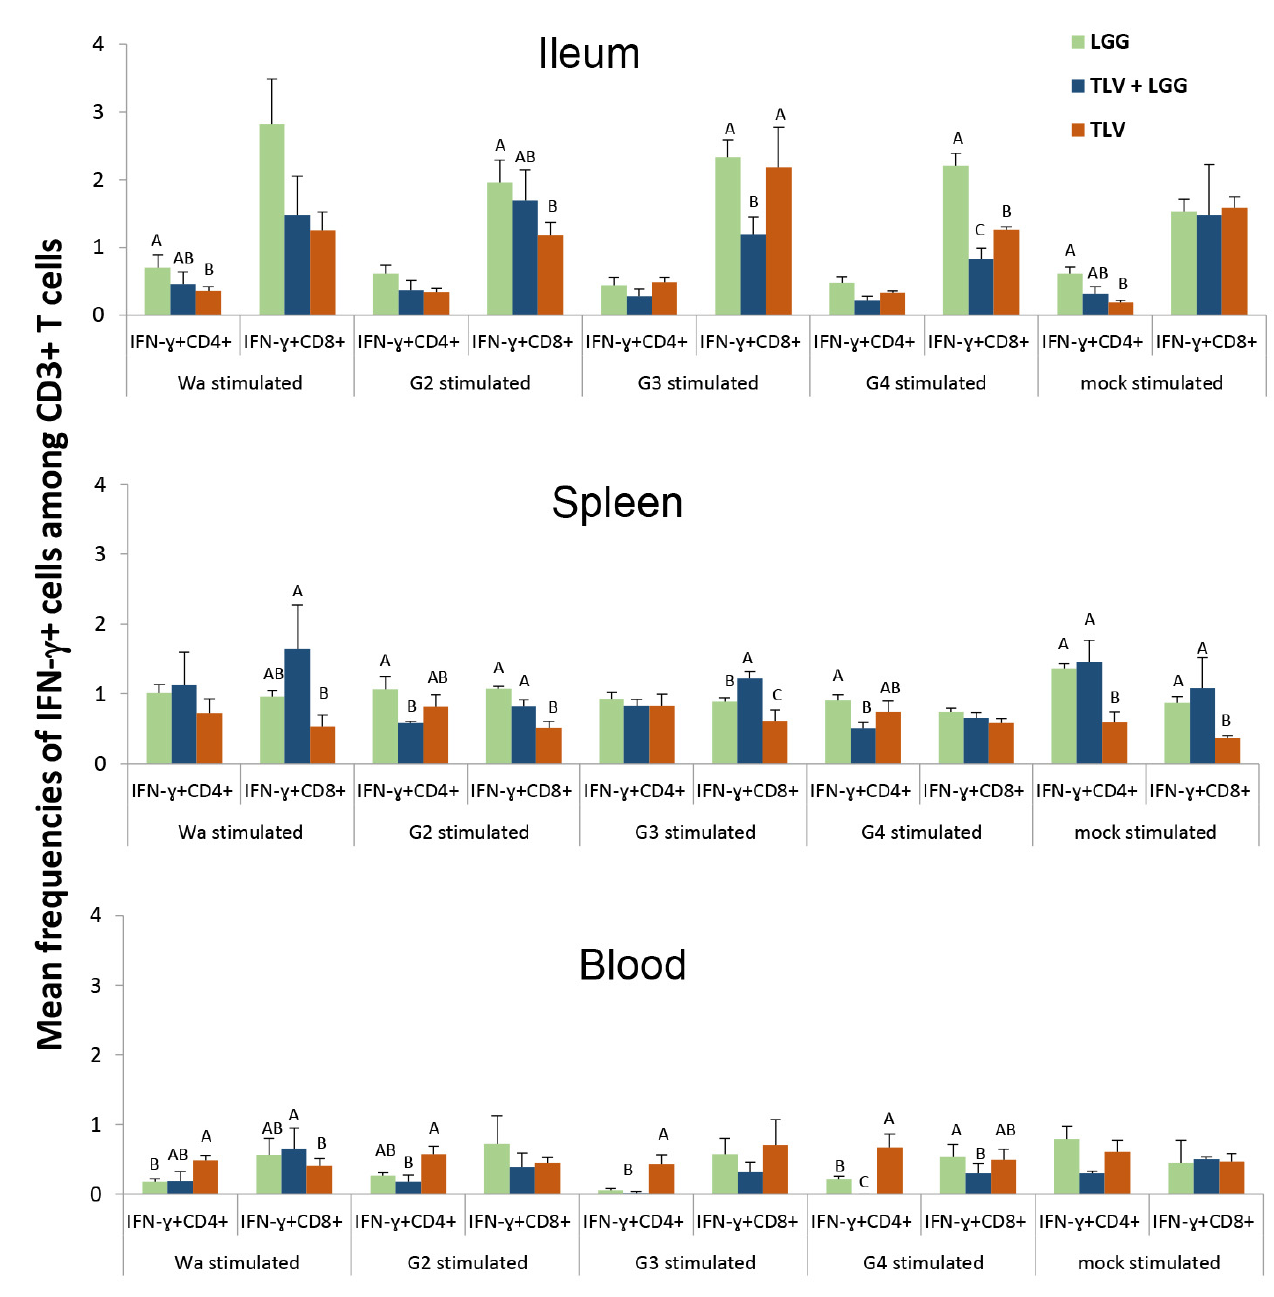
Figure 11. Frequencies of IFN- γ +CD4+ and IFN- γ +CD8+ T cells in the intestinal and systemic lymphoid tissues of Gn pigs in the TLV+LGG, TLV, and LGG groups at PCD 7 detected by flow cytometry. The MNC were stimulated in vitro for 17 h with semi-purified whole Wa HRV, G2, G3 and G4 VP7 antigens, or mock stimulated. Bars with different uppercase letters (A, B) indicate significant differences among groups for the same cell type, while shared letters indicate no difference (Kruskal–Wallis test, p <